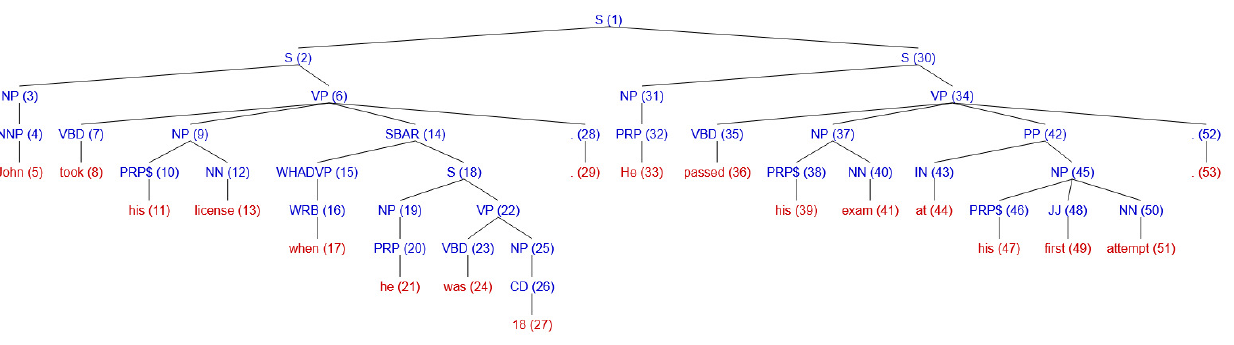
Figure 1. Sample parse tree for two sentences with several